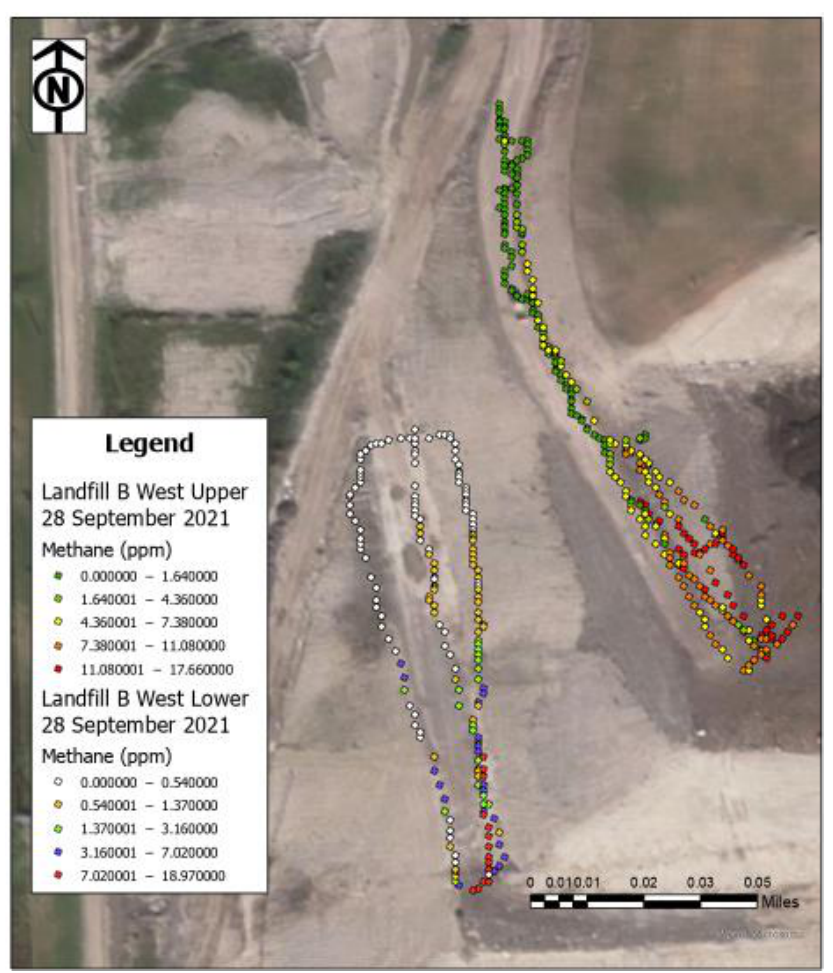
Figure 14. DR1000 measurements of methane for the Western Flux Plane at Facility B on 28 Figure 14. September 2021. 28 September